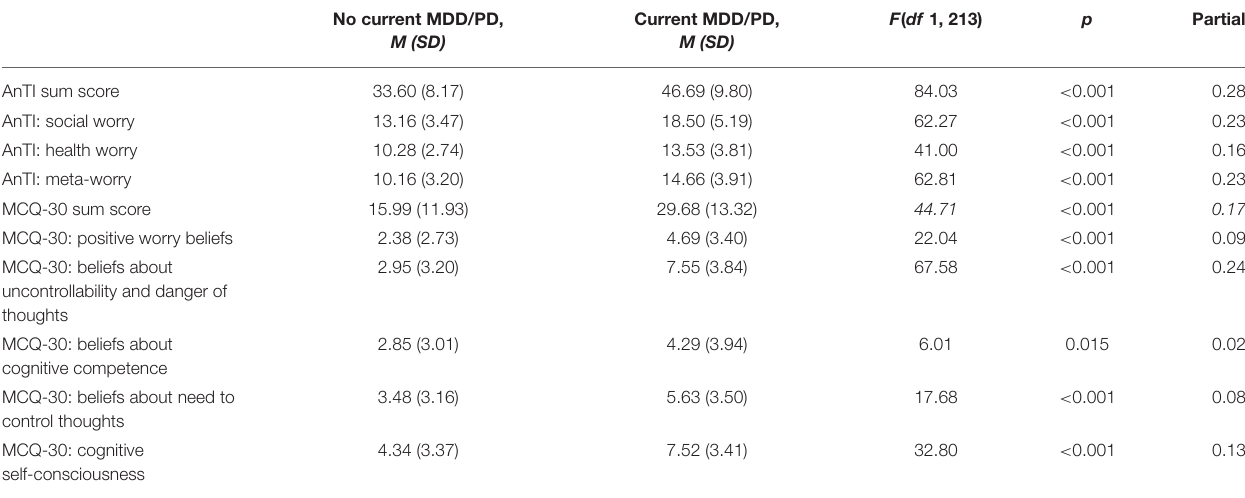
TABLE 3 | Mean scores of the AnTI and MCQ-30 and their subscales in patients with and without current